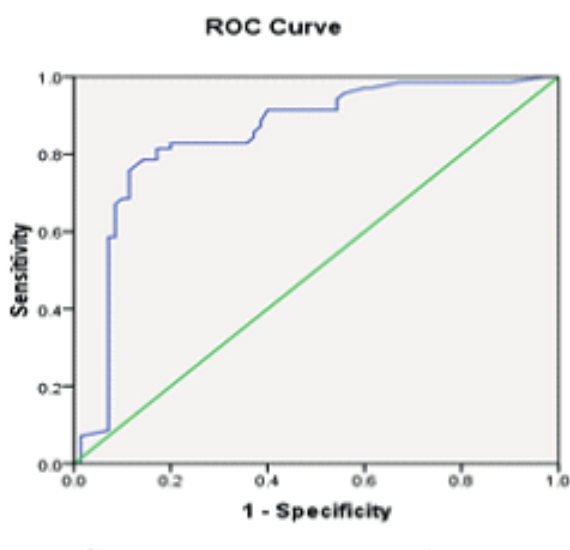
Figure 1: Diagnostic performance of IMA as risk marker in diabetic patients, AUC=0.84. Sensitivity=81.4% and specificity=80% at cut off value